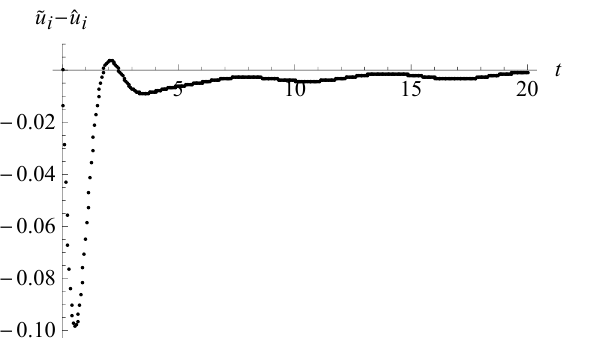
Figure 4. The difference ˜ u i − ˆ u i between the high-precision inverse Laplace transform numerical solutions and the L 1– L 2 numerical solutions ( h =